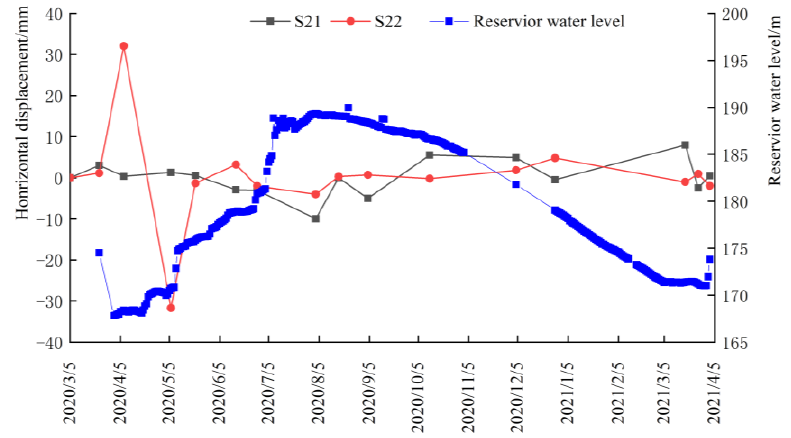
Figure 8. 2 # section horizontal displacement duration curve (upstream is − , downstream is +).